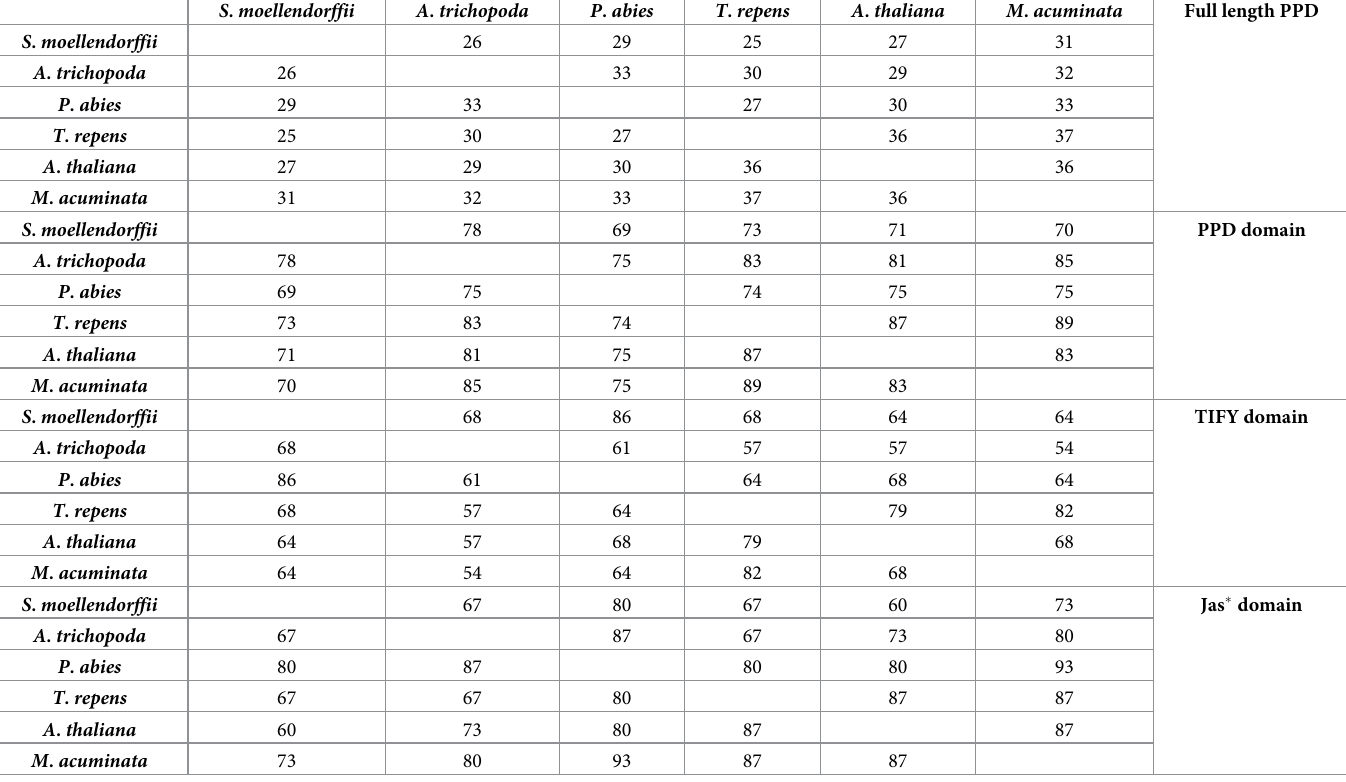
Table 1. Sequence identity across full sequences and distinct domains of PPD